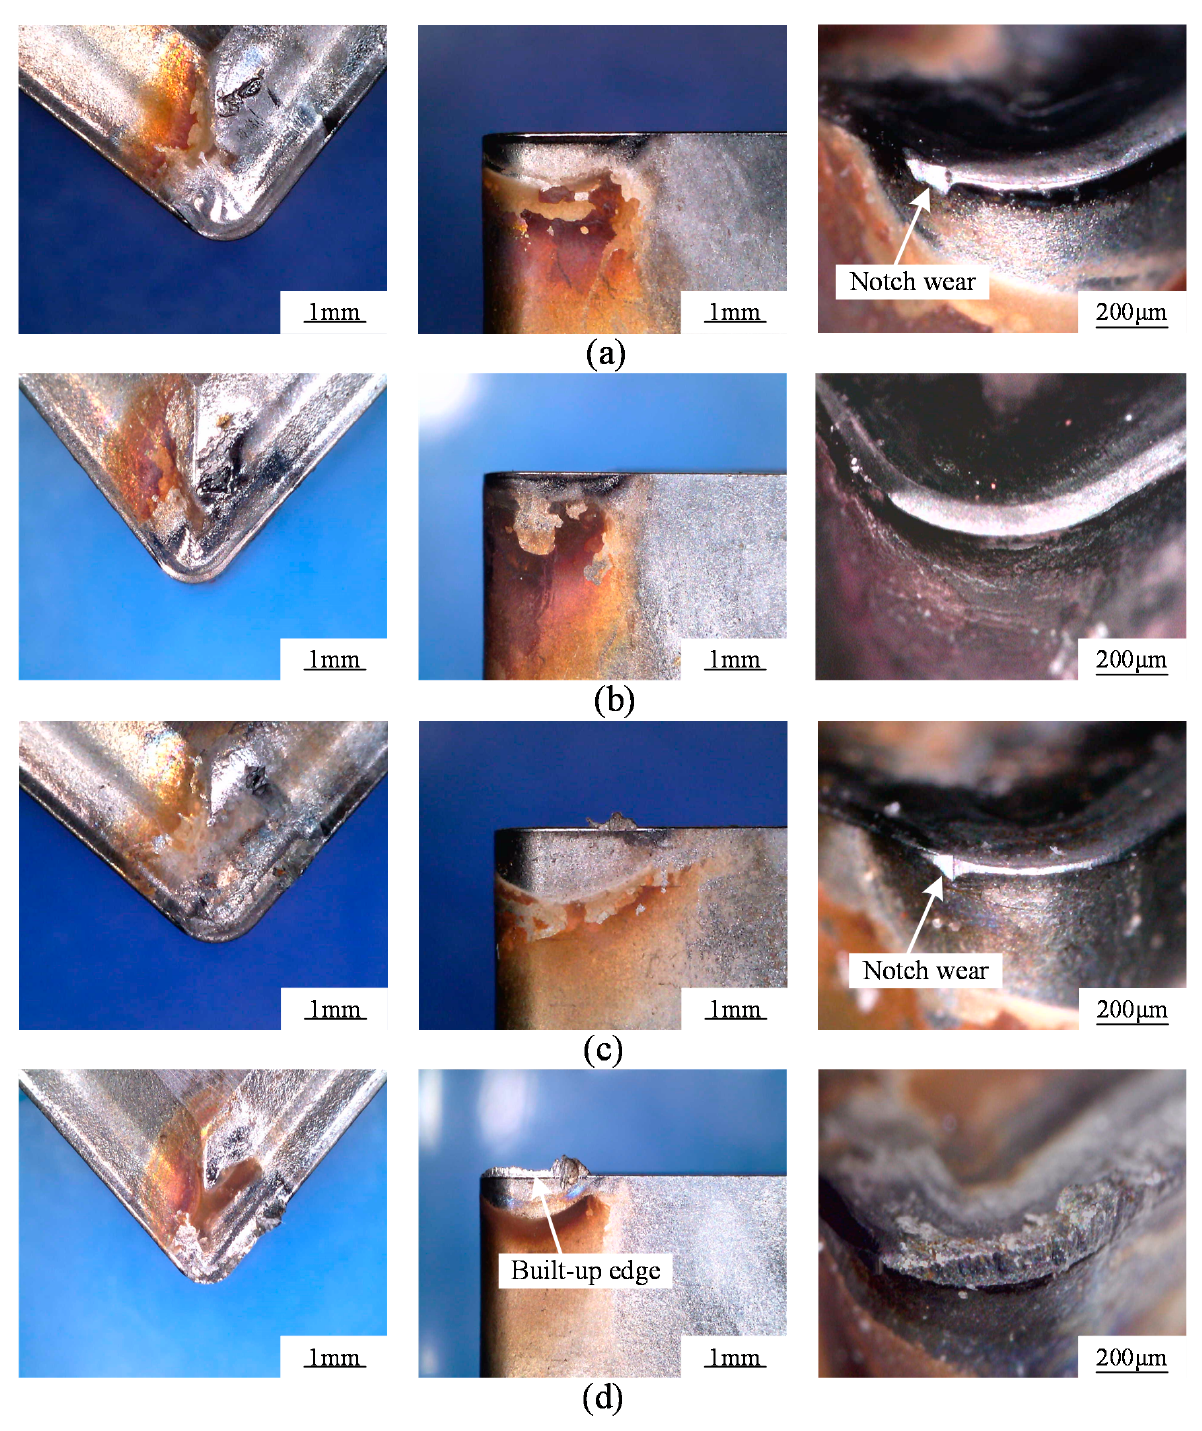
Figure 4. Wear morphologies of cermet tools at both cutting speeds: ( a ) NX2525 and ( b ) TN620 at 40 m/min for 41 min, and ( c ) NX2525 and ( d ) TN620 at 80 m/min for 15 min.